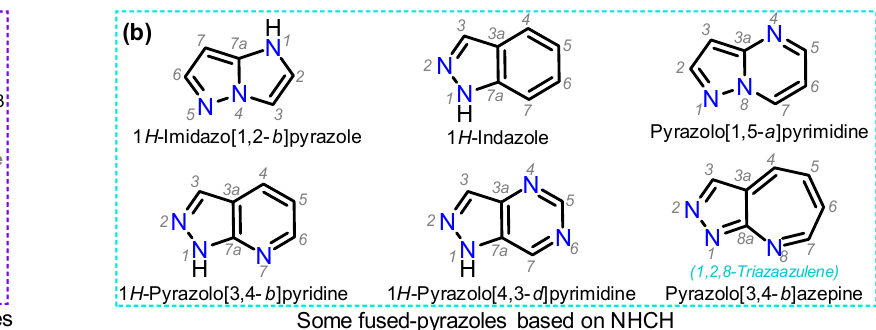
Figure 1. Structure of ( a ) NH -pyrazoles and ( b ) some fused pyrazoles with peripheral numbering.